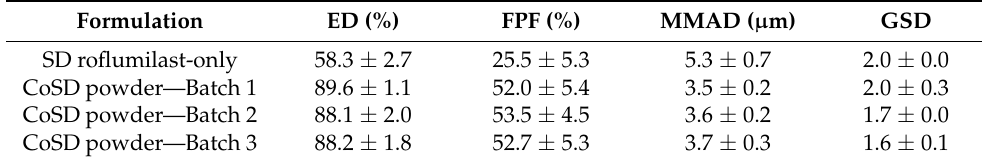
Table 5. In vitro aerosolization (emitted dose (ED), fine particle fraction (FPF)) and aerodynamic properties (mass median aerodynamic diameter (MMAD), geometric standard deviation (GSD)) of spray-dried (SD) and cospray-dried (CoSD) roflumilast powders. Formulation ED (%) FPF